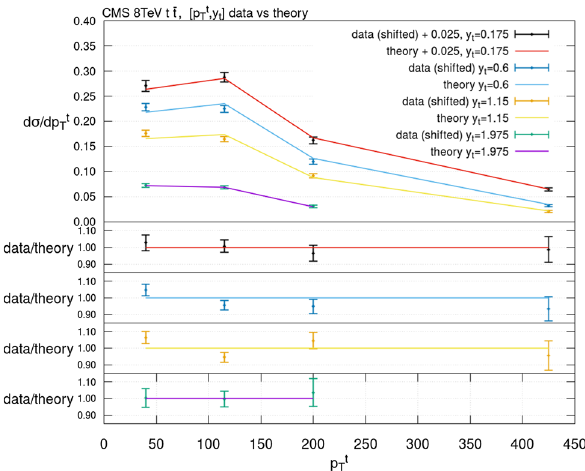
Fig. 15 Data vs. MSHT20 NNLO theory for the CMS 8 TeV t ¯ t data , y ] . The errors plotted here are the total uncorrelated differential in [ p t t T errors for each point which is the quadrature sum of the statistical and PDF errors for that